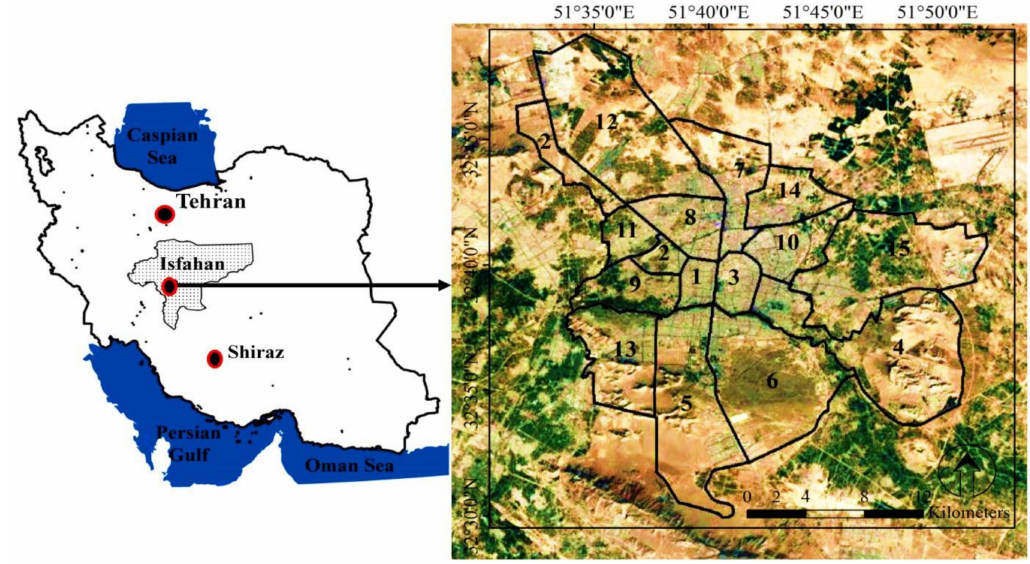
Figure 1. Location of Isfahan metropolis (study area) in Iran and illustration of its 15 management